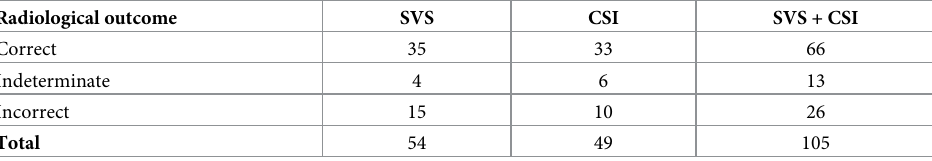
Table 8. Radiological outcome with the different spectroscopic